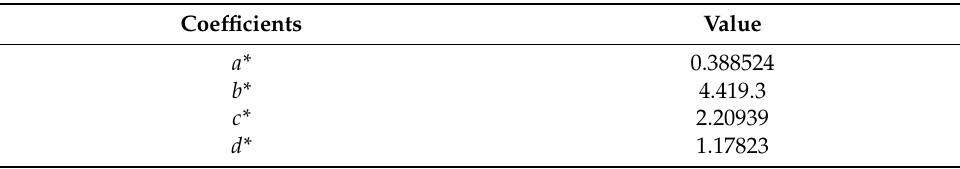
Figure 14. Results of the optimization procedure—coefficients (Equations (1) and (2)): ( a ) ( a , b ) and ( b ) ( c , d ) . Table 7. Optimal values of the coefficients that describe